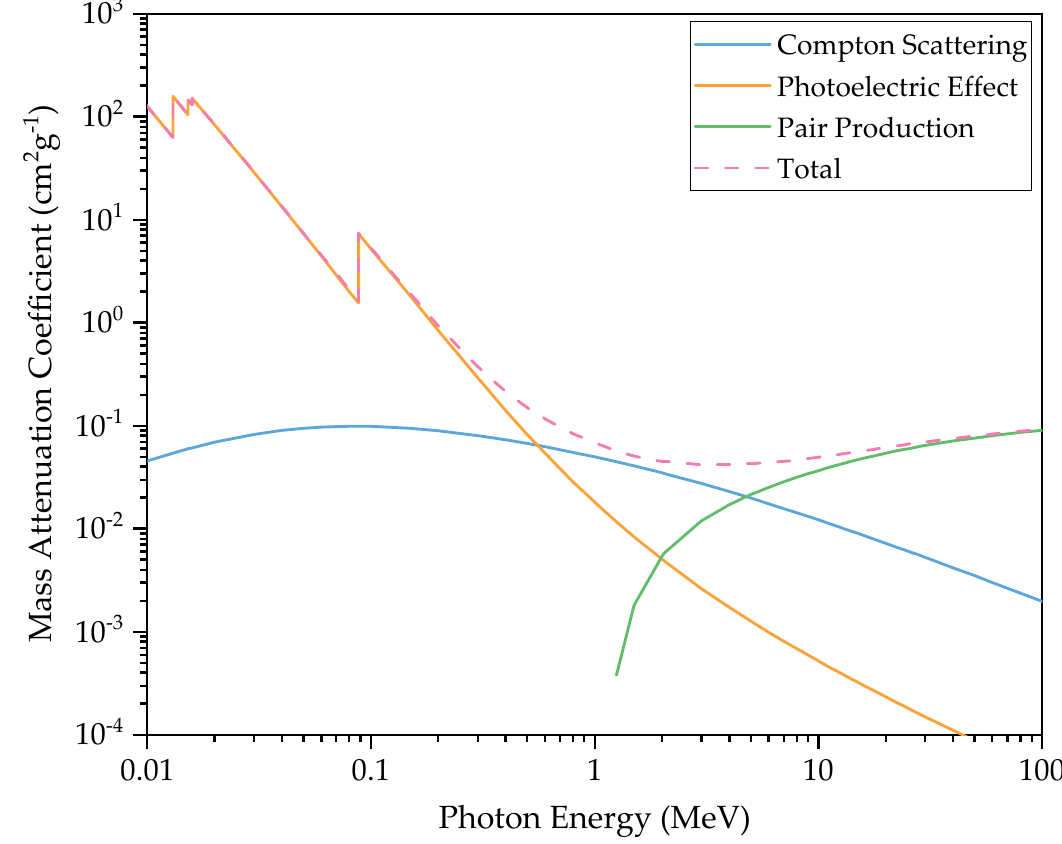
Figure 2. Mass attenuation coefficients in Pb for the γ interaction mechanisms: Compton scattering (blue), photoelectric effect (orange), pair production (green) and total interaction cross section (pink) across the 10 1 –10 5 keV energy range. Data from